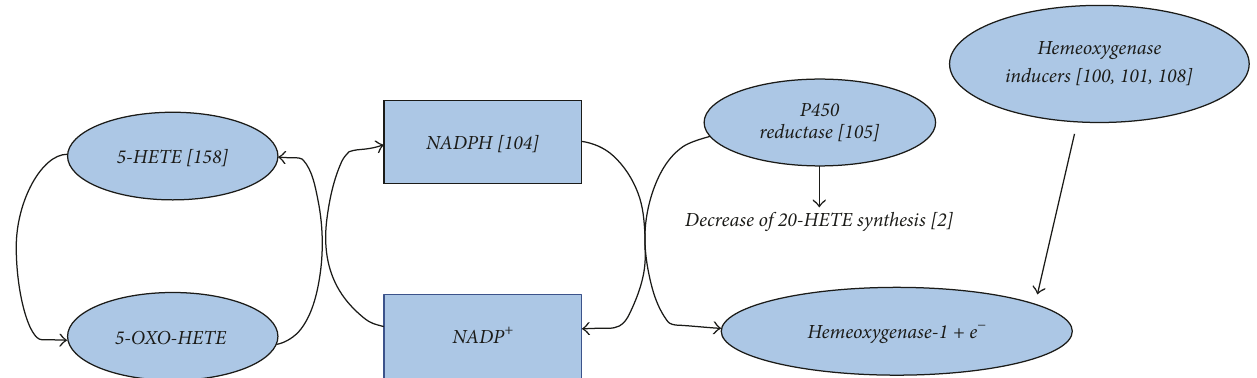
Figure 6: Proposed mechanism of heme oxygenase inducer application to overcome accumulation of toxic metabolites [102, 104, 105] induced by NSAIDs. Induction of heme oxygenase by several agents [100, 101, 108] and receival of electrons via P450 [103, 105] may result in decreased formation of 20-HETE and 5-OXO-ETE toxic metabolite